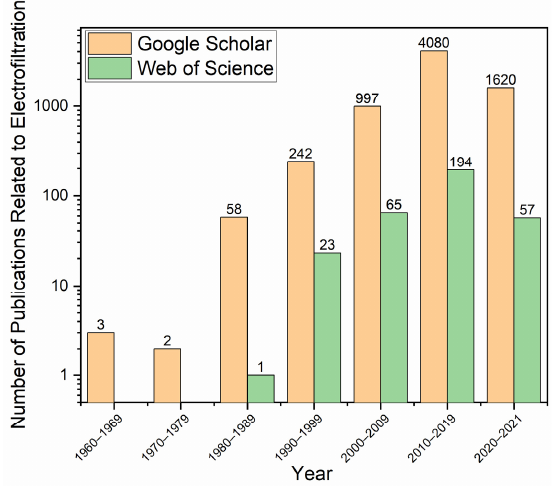
Figure 1 Figure 1. Number of results returned from Google Scholar and Web of Science by searching with ‘electric field’ and ‘membrane filtration’. Database searched included: 2; Total results shown: 7342; Numbers selected: